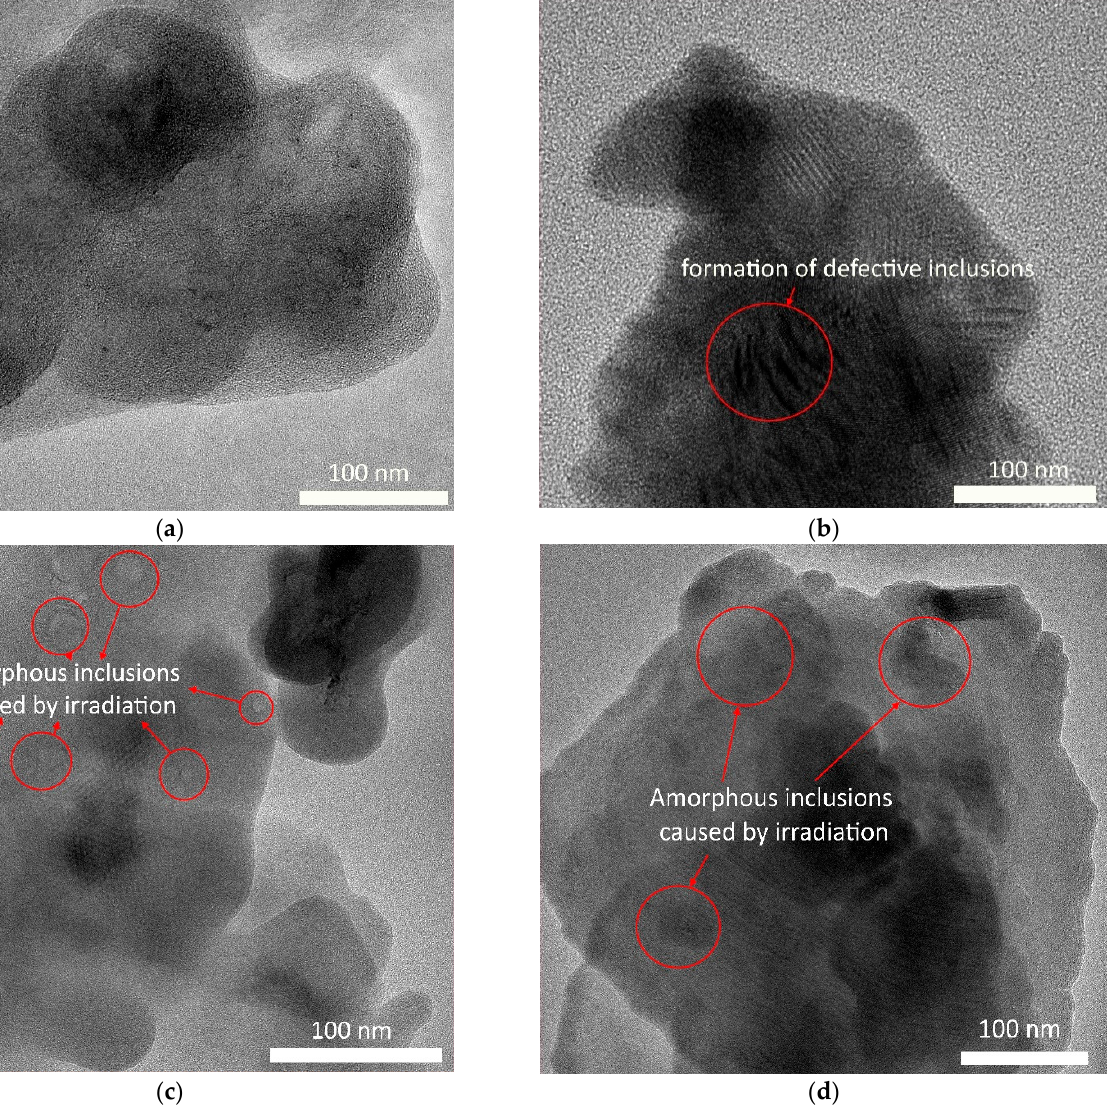
Figure 4. TEM images of the studied ceramics before and after irradiation: ( a ) pristine sample; ( b ) 10 20 ion/m 2 ; ( c ) 5 × 10 21 ion/m 2 ; ( d ) 10 22 ion/m 2 .